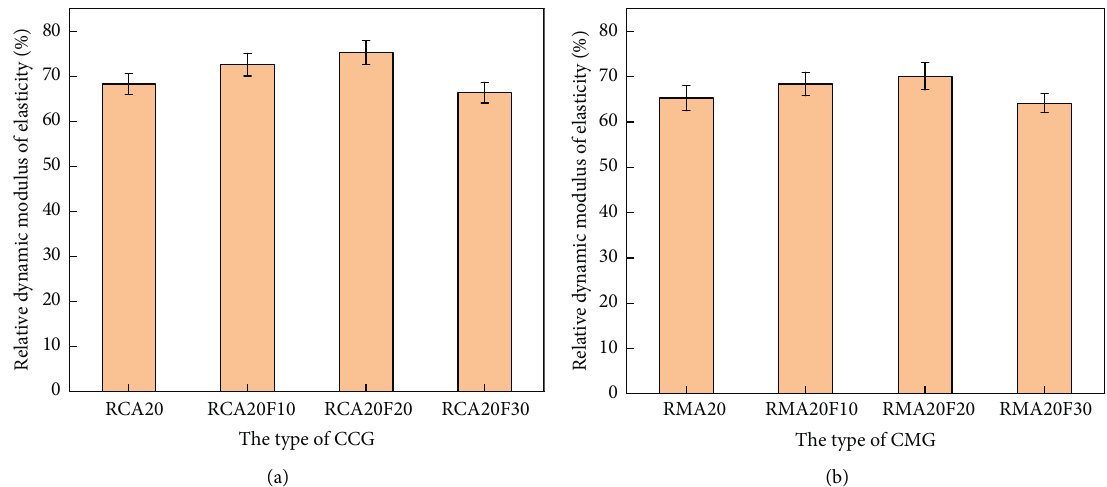
Figure 9: The relative dynamic modulus of elasticity of CCG and CMG with different content of fly ash. (a) CCG, (b)